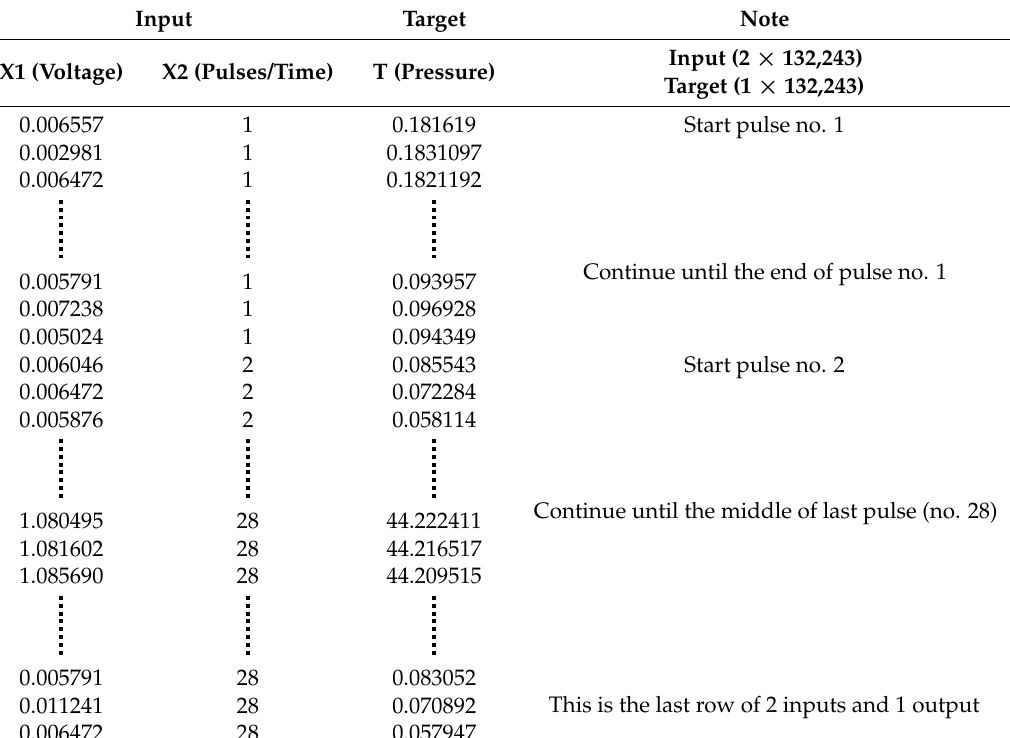
Table 2. The inputs and target data set used for neural network training.